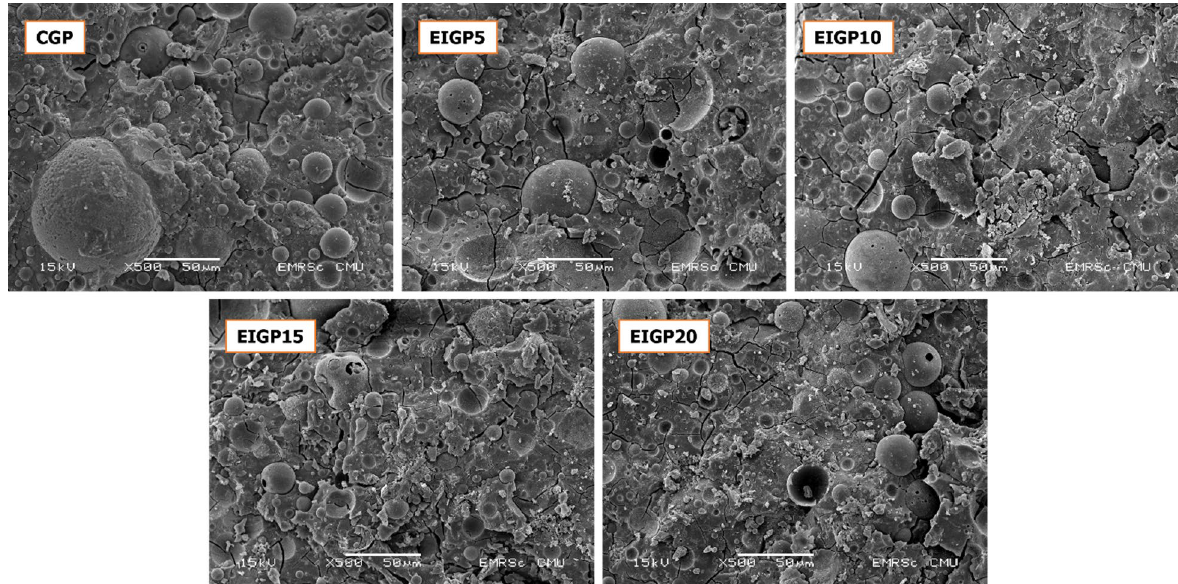
Figure 9. The SEM images of CGP and EIGP samples after 28 days of curing at 500 × magnification.